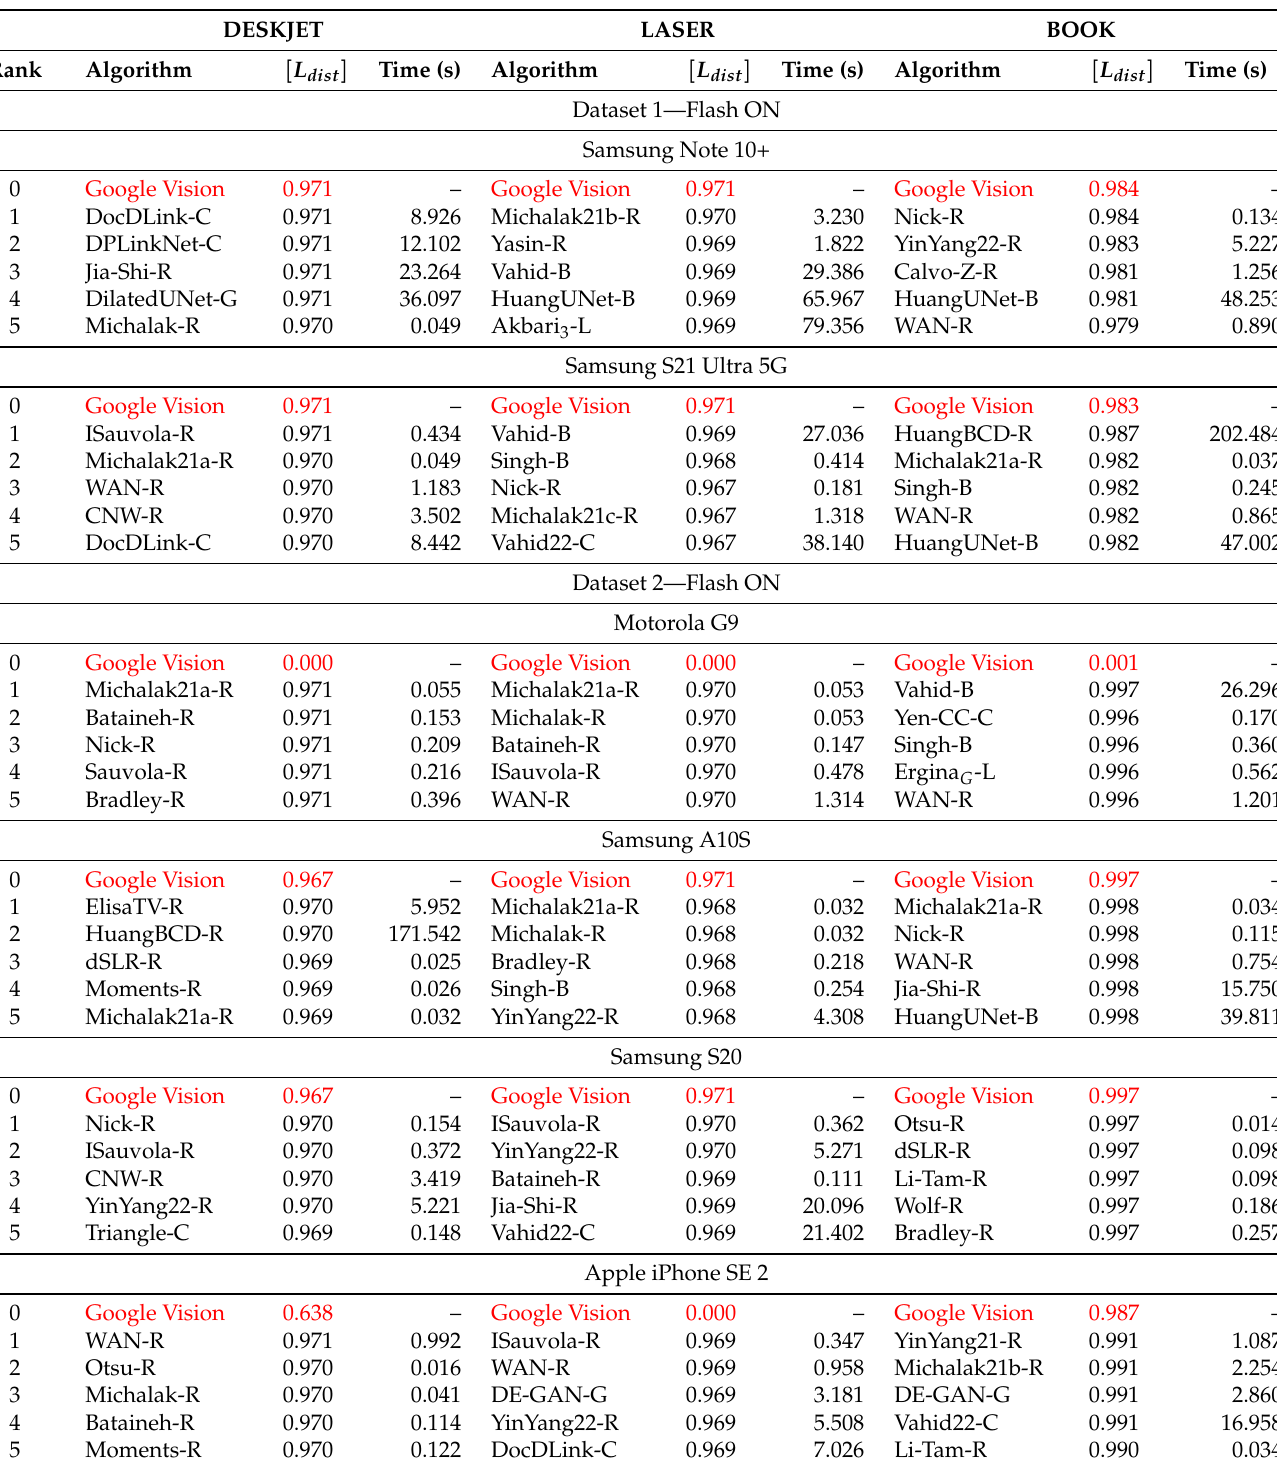
Table 8. Summary of results with Ldist measure and flash ON sorted according to the